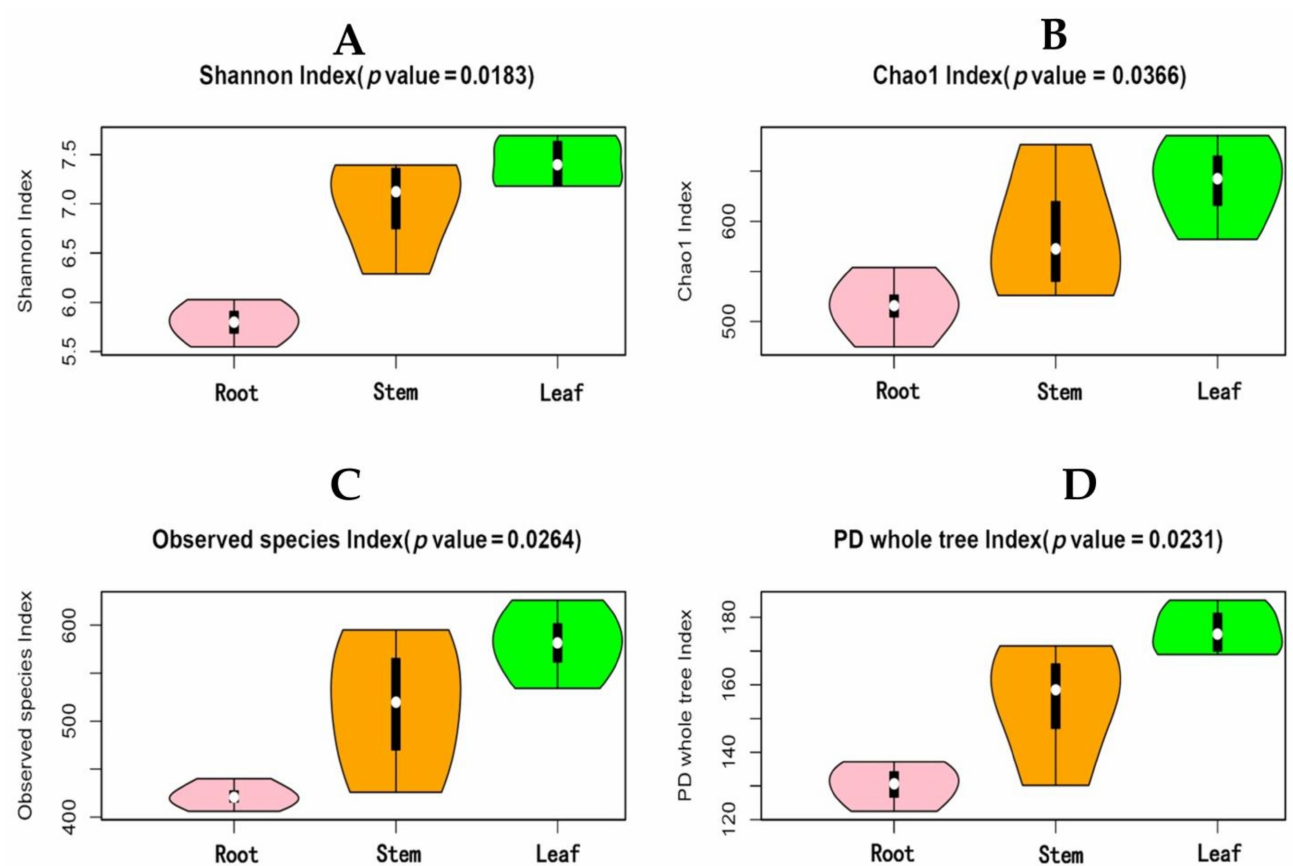
Figure 3. The alpha diversity index of the endophytic fungi isolated from different plant organs of H. serrata. ( A – D ) are indicating Shannon index, Chao1 index, Observed species index and Phylogenetic diversity (PD) tree index respectively.